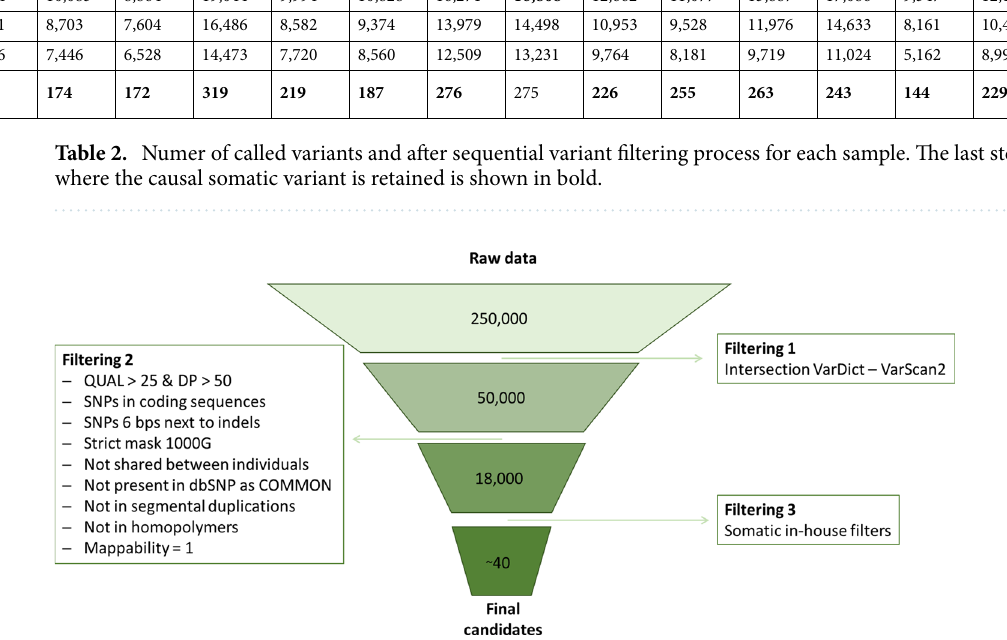
Figure 2. Filtering process followed to obtain somatic candidate variants. We got around 40 variants per blood sample that we then experimentally validated by